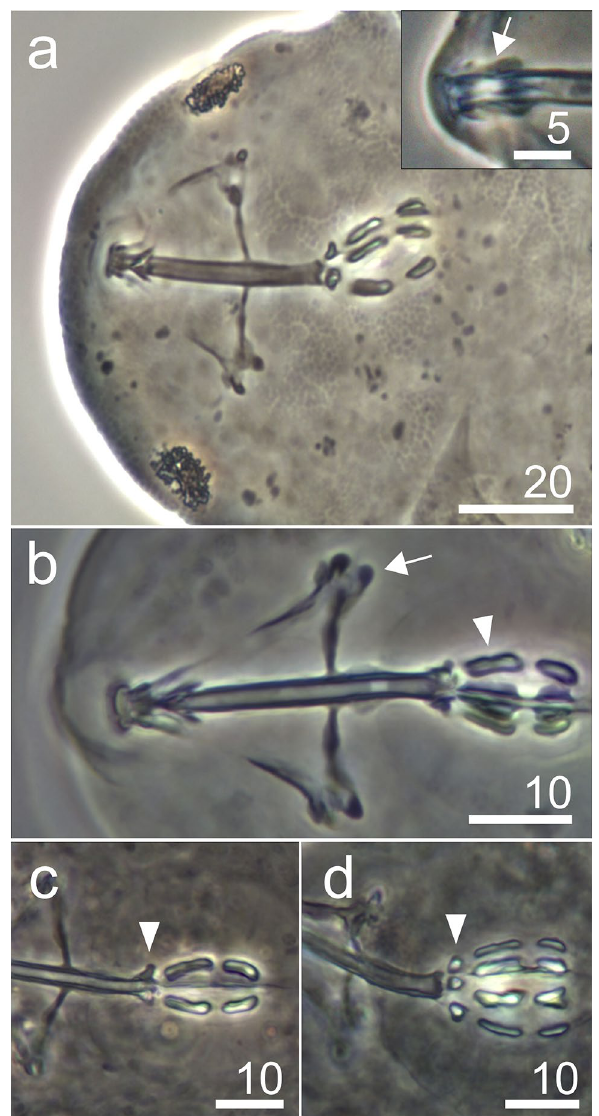
Figure 5. Hypsibius nivalis sp. nov., bucco-pharyngeal structures (PCM): ( a ) cephalic part, buccal apparatus and eyes, holotype, insert are AISM, ( b ) buccal apparatus, arrow indicates typical Hypsibius type furcae, arrowhead indicates incision in the first macroplacoid, paratype, ( c,d ) apophyses (arrowhead) and